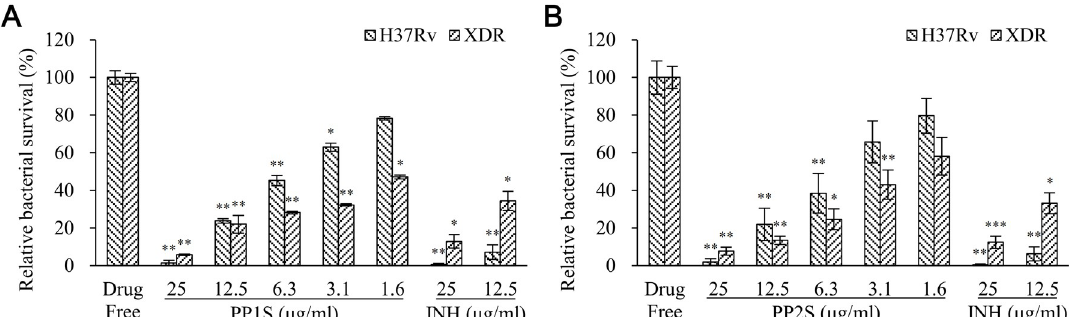
Fig 3. Intracellular killing activities of PPs for M . tuberculosis . Inhibitory effects of (A) PP1S and (B) PP2S on M . tuberculosis H37Rv and XDR M . tuberculosis infected in macrophages were analyzed through an intracellular antimycobacterial activity test. (A and B) Survival of M . tuberculosis in macrophages was quantified by a CFU assay. Experiments were performed in triplicate and repeated 3 times. Data are presented as mean ± SD and Student t test was used to compare groups ( � p < 0.05, �� p < 0.01). CFU, colony-forming units; INH, isoniazid; PP, methyl (S)-1-((3-alkoxy-6,7-dimethoxyphenanthren-9-yl)methyl)-5-oxopyrrolidine-2-carboxylate; XDR, extensively drug-resistant. Data underlying this Figure can be found in S1 Data.